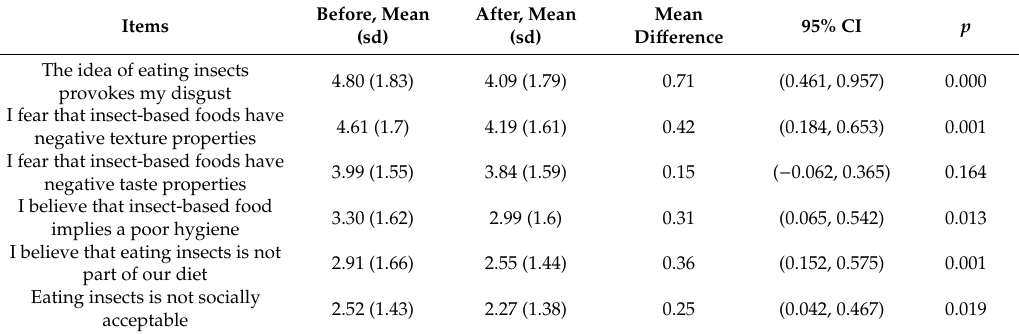
Table 2. Mean values and 95% confidence intervals (CI) for the insect food rejection items, before and after the informative seminar (n =